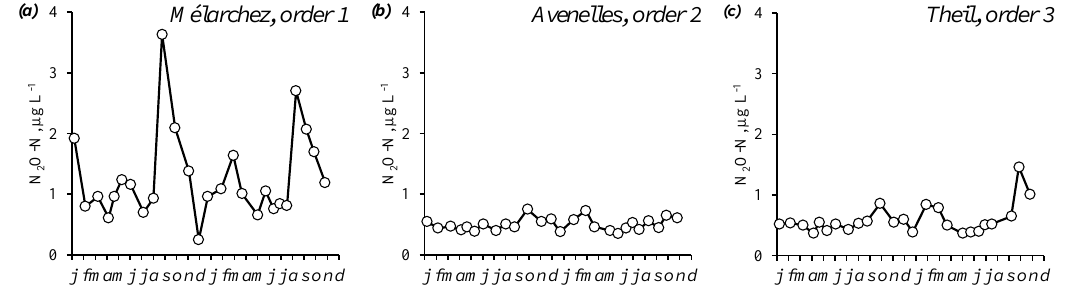
Fig. 3. Nitrous oxide concentrations between January 2007 and December 2008 in rivers at: (a) M´elarchez, first order; (b) Avenelles, second order and (c) Theil, third